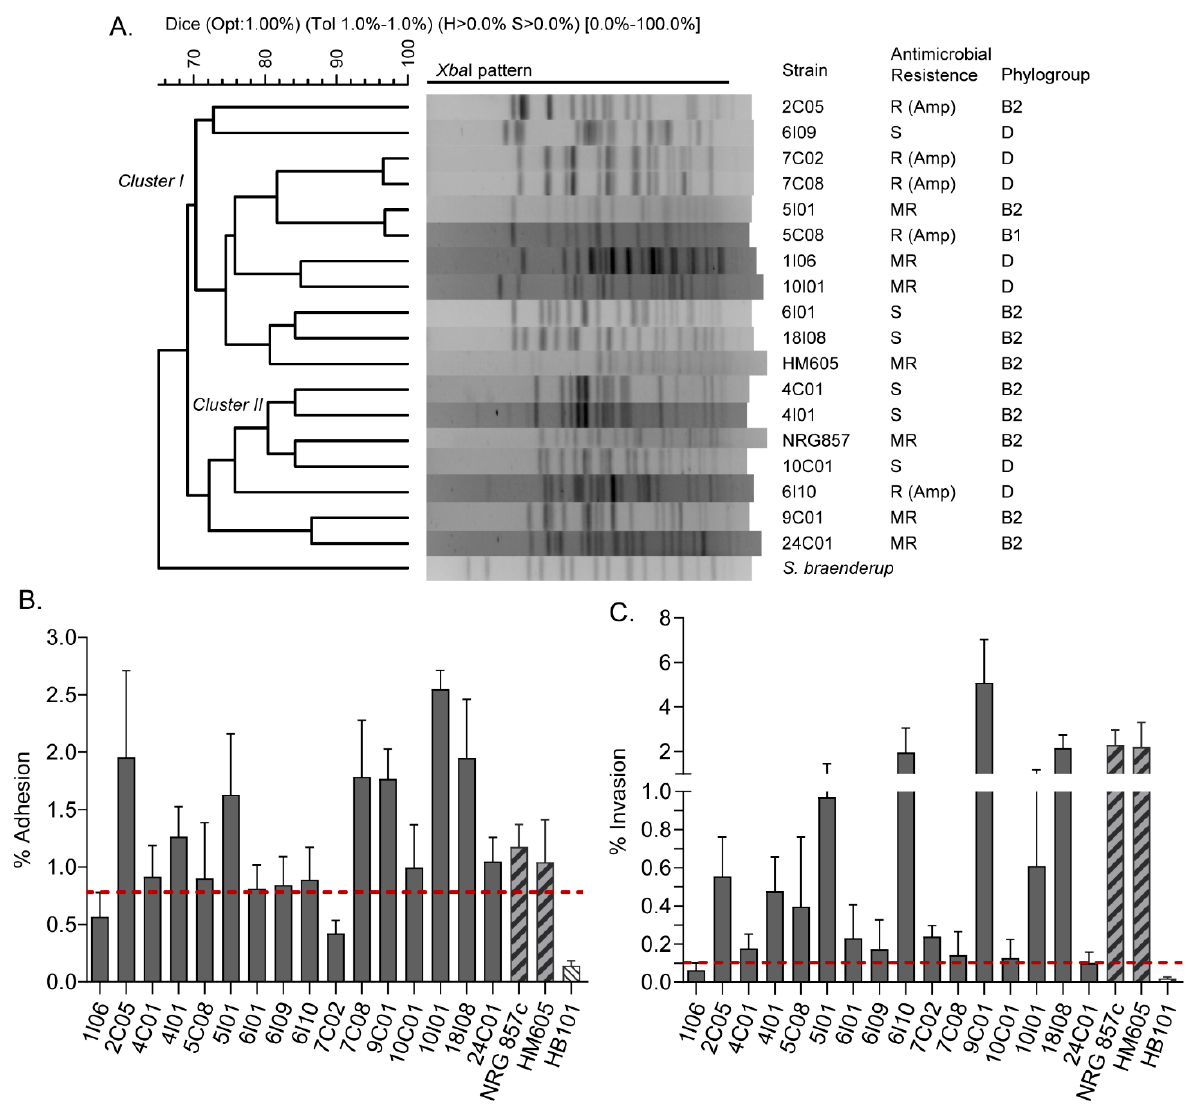
Figure 1. PFGE analysis and phenotypic characterization of 16 E. coli strains isolated from patients with Crohn’s disease included in this study. ( A ) Dendrogram generated with Xba I-digested PFGE patterns. Phylogenetic groups, antibiotic resistance and the two main clusters (I and II) are indicated. AIEC reference strains HM605 and NRG857c are also included. Strain resistance to eight antibiotics (gentamicin, ciprofloxacin, chloramphenicol, cefotaxime, ampicillin, cefepime, trimethoprim-sulfamethoxazole, and nalidixic acid) was evaluated. S: sensitive; A: resistant; MR: multi-resistant (strain resistant to more than one antibiotic). ( B ) Bacterial adhesion to Caco-2 cells. Error bars represent SD ( n = 3). ( C ) Bacterial invasion to Caco-2 cells. Error bars represent s.d. ( n = 3). The dotted red line indicates the cut-off value to consider the strains as adherent or invasive (see Materials and Methods section). Table 2. Ability of E. coli strains to survive within RAW 264.7 macrophages *.